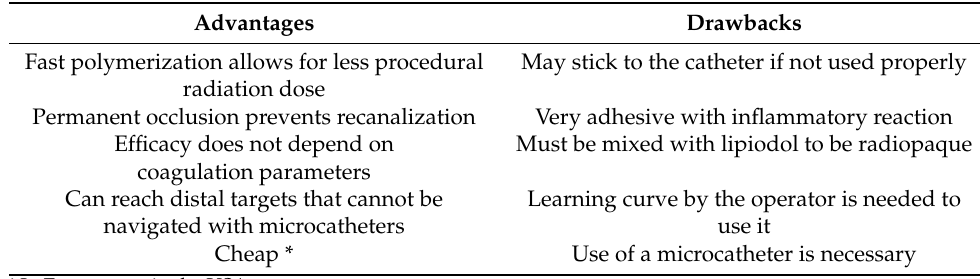
Table 5. Advantages and drawbacks of cyanoacrylate glues. Advantages Drawbacks Fast polymerization allows for less procedural radiation dose Permanent occlusion prevents